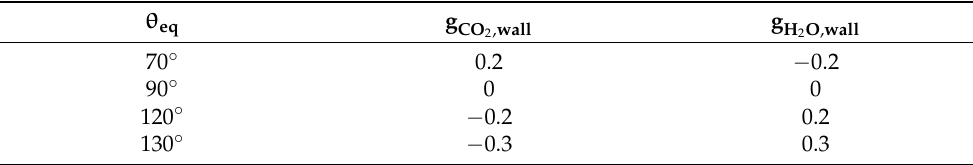
and g for different contact CO 2 ,wall H 2 O,wall